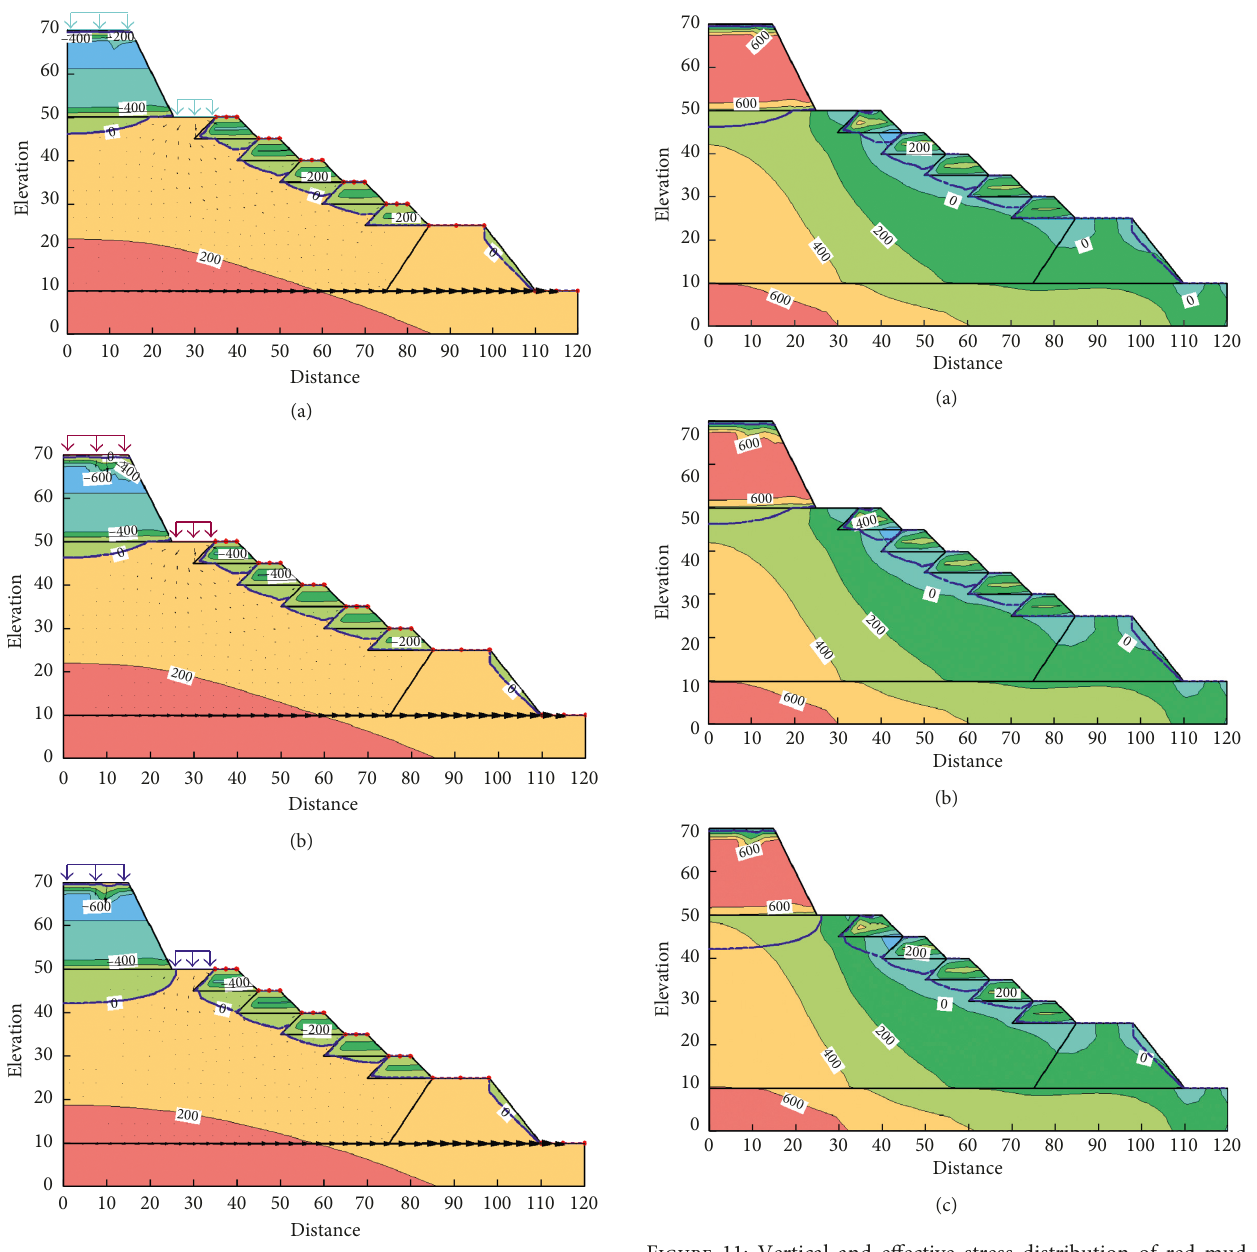
Figure 11: Vertical and effective stress distribution of red mud stockpile under different rainfall conditions: (a) rainfall condition I, (b) rainfall condition II, and (c) rainfall condition